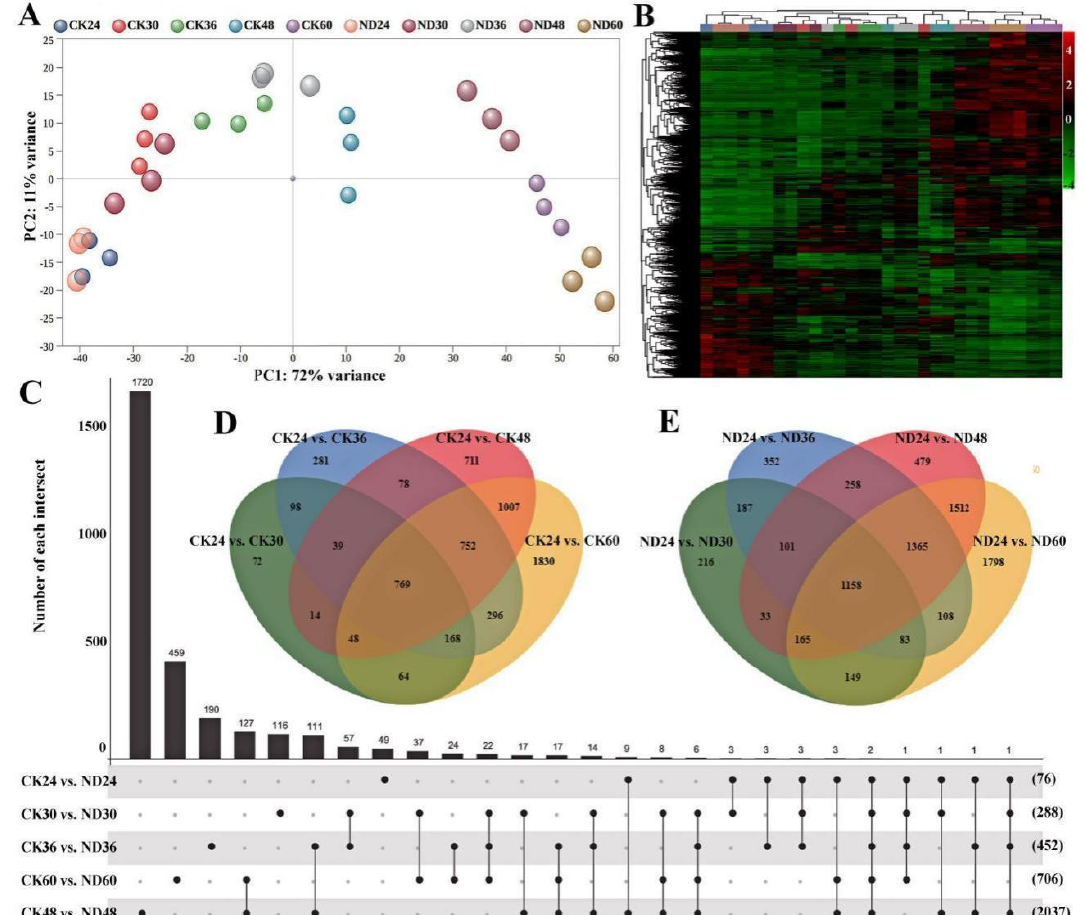
Figure 3. Gene expression profiling and the number of differentially expressed genes (DEGs) analysis in responding to the infection and colonization of C. globosum strain ND35 in cucumber radicle. ( A ): Principal Component Analysis (PCA) plots showing the differences between samples according to the genes expression; ( B ): Hierarchical clustering analysis showing the expression patterns of differentially expressed genes (DEGs) in different treatments, the color represents the expression level of differential genes (log2), the red represents the higher expression levels genes, and the green represents lower expression levels genes; ( C – E ): Venn diagrams showing overlap of DEGs between different treatments.